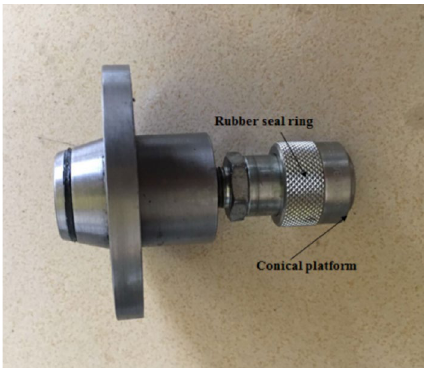
Figure 2 Sealing the end of the object